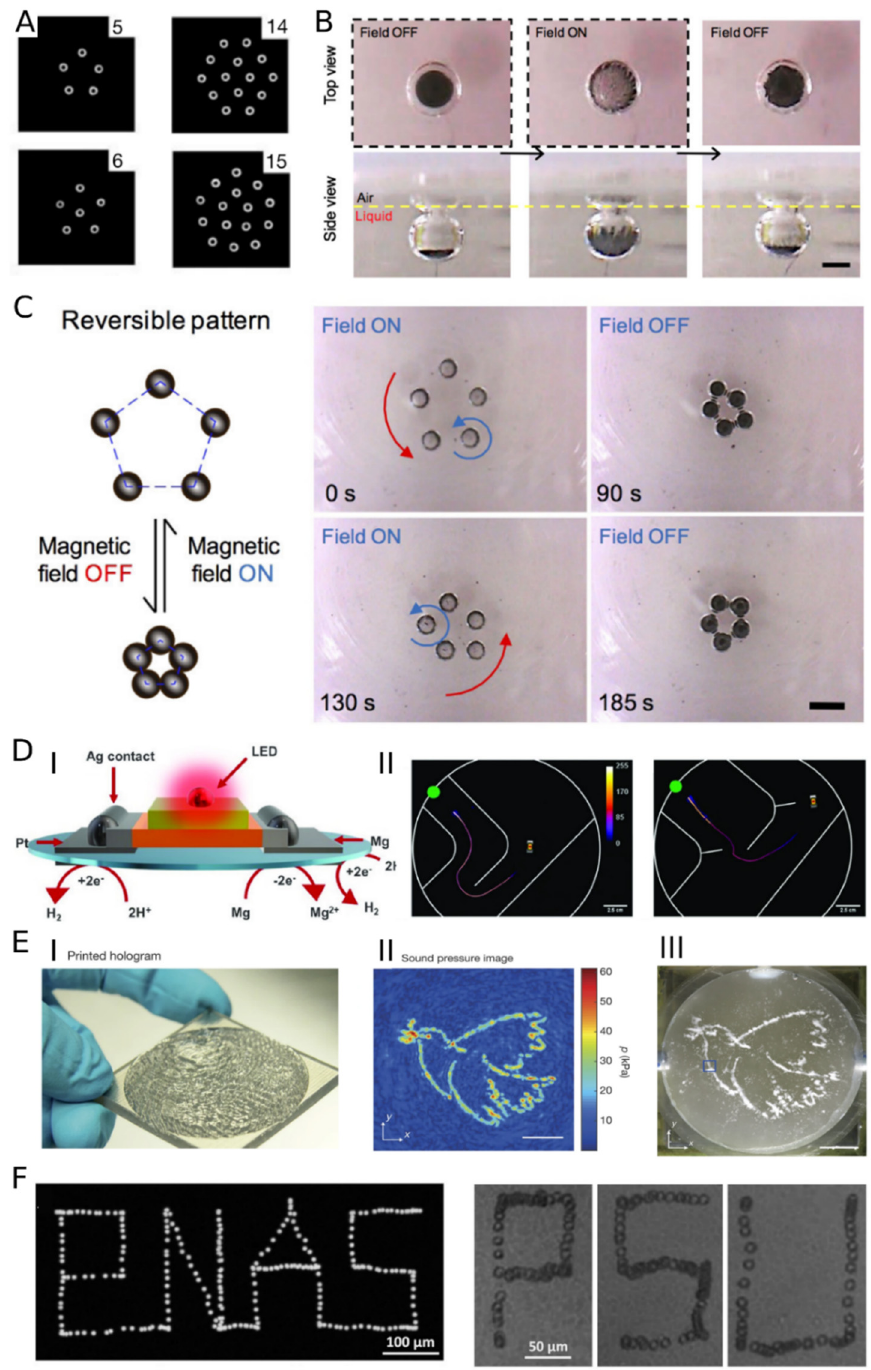
Figure 7. ( A ) Exemplary dynamic patterns of magnetic disks presented by Grzybowski et al. [282]. Adapted with permission from ref. [282]. Copyright 2000 Springer Nature. ( B ) Droplets of a water suspension of magnetic microparticles and their dynamic self-assembly in the external magnetic field (scale bar = 1 mm). Adapted with permission from ref. [283]. Copyright 2019 American Chemical Society. ( C ) Dynamic adjustments of the distance between self-assembled droplets in the external magnetic field (scale bar = 4 mm). Adapted with permission from ref. [283]. Copyright 2019. American Chemical Society. ( D ) An example of a microswimmer. ( I ) Light-emitting microswimmers and reactions occurring in the movement. ( II ) The registered trajectories of the moving microswimmer. Scale bar: 2.5 cm. Figure D was adapted based on Creative Commons license from ref. [290]. Copyright 2020 Wiley. ( E ) ( I ) The printed hologram allows for receiving calculated sound pressure patterns. ( II ) The sound pressure pattern, and ( III ) the pattern obtained with the particles.